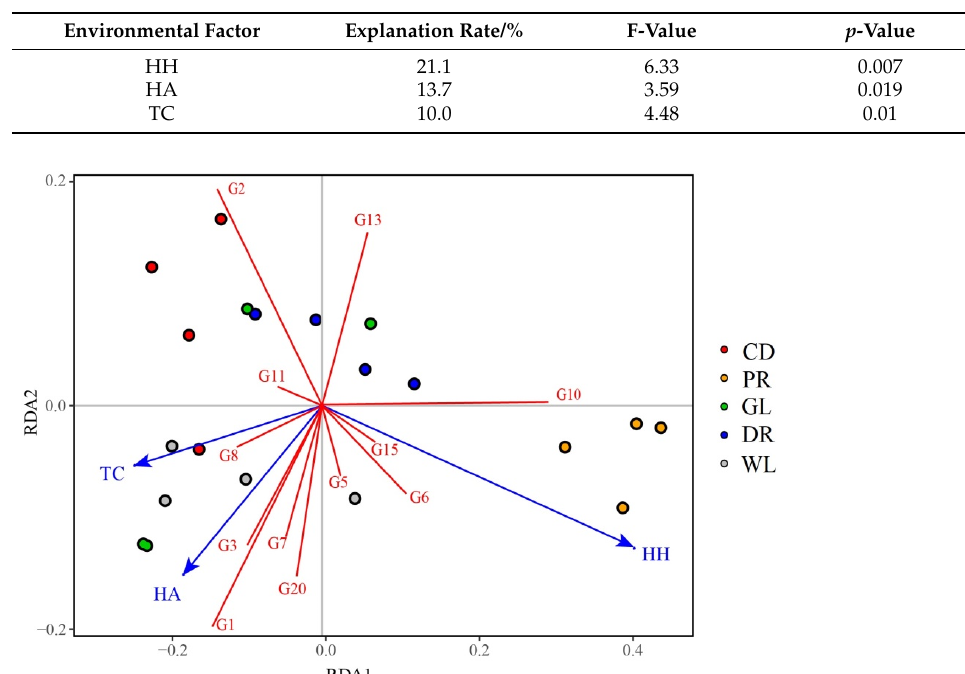
Figure 6. Ecological network structure diagram of natural enemies, insect herbivores, and neutrals within adjacent arable land with artificial and semi-natural field margins. The dots represent the species of arthropods (Table S1), and the size of the dots is proportional to the abundance. The connection between points showed a significant correlation (r > 0.8, p < 0.01). GL, WL, CD, DR, and PR represent grassland, woodland, irrigation canals and ditches, dirt roads, and paved roads. Table 3. Monte Carlo significance test of environmental factors in relation to the RDA models. Tree layer cover (TC), herbage layer abundance (HA), and herb layer height (HH).